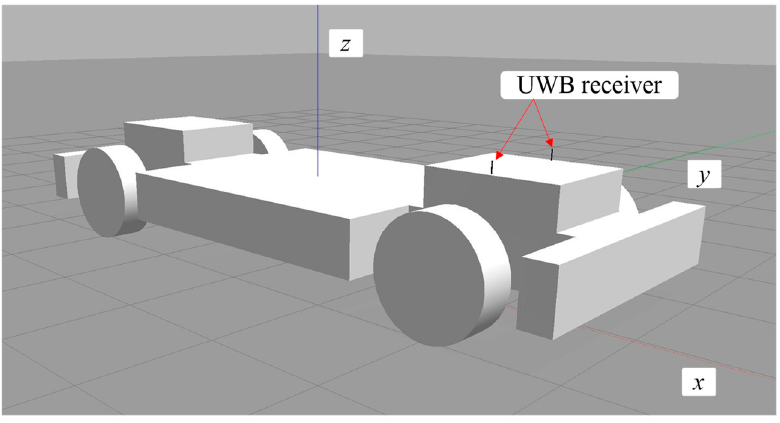
Figure 4. Simulation model of WLR-5A.